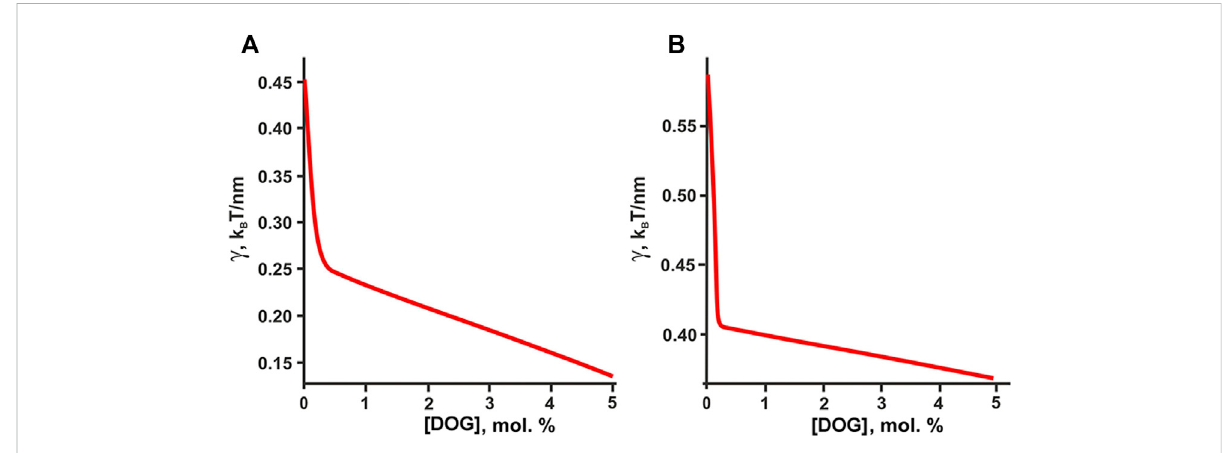
FIGURE 8 Calculated dependence of the line tension of the raft boundary on the total DOG content in the eSM:DOPC:Chol membrane. (A) eSM/DOPC/ Chol = 1:1:1. (B) eSM/DOPC/Chol =